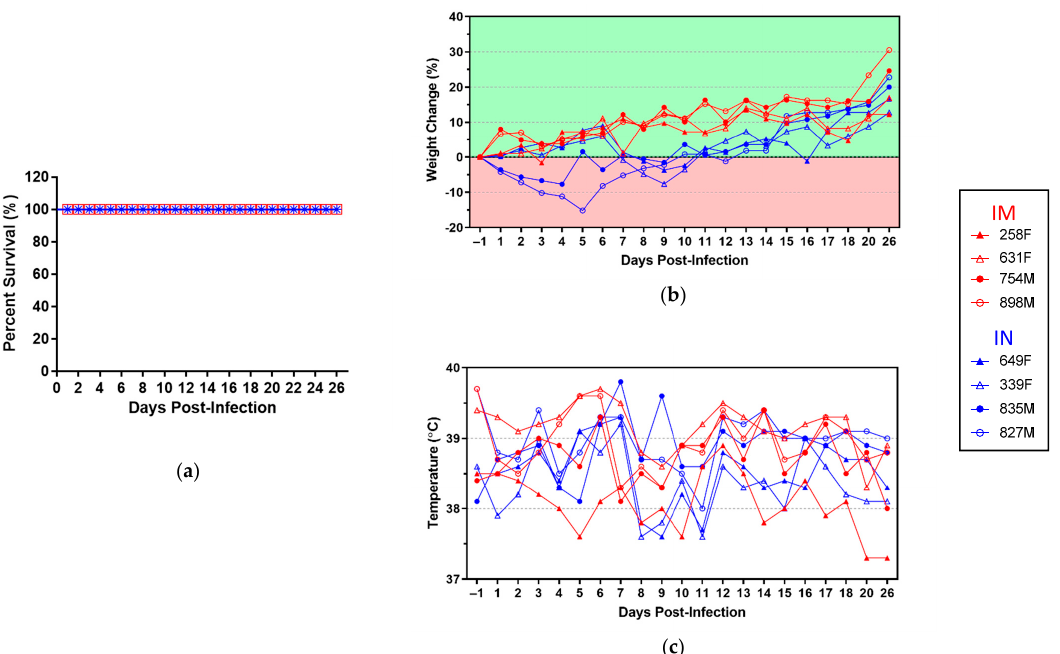
Figure 2. Clinical parameters of TAFV-infected ferrets. Survival curves ( a ), percent weight change ( b ), and temperature ( c ) for each animal over the duration of the study. Individual animal IDs and sex (F/M) are indicated in the key. IM, intramuscular inoculation; IN, intranasal